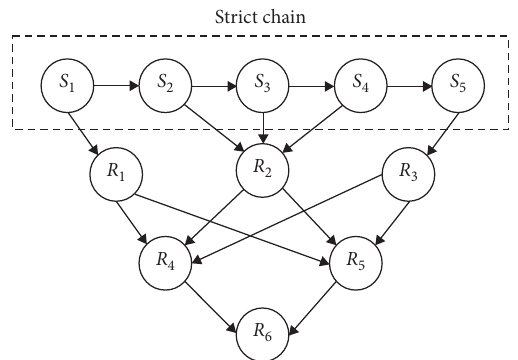
Figure 1: Bayesian network under a strict